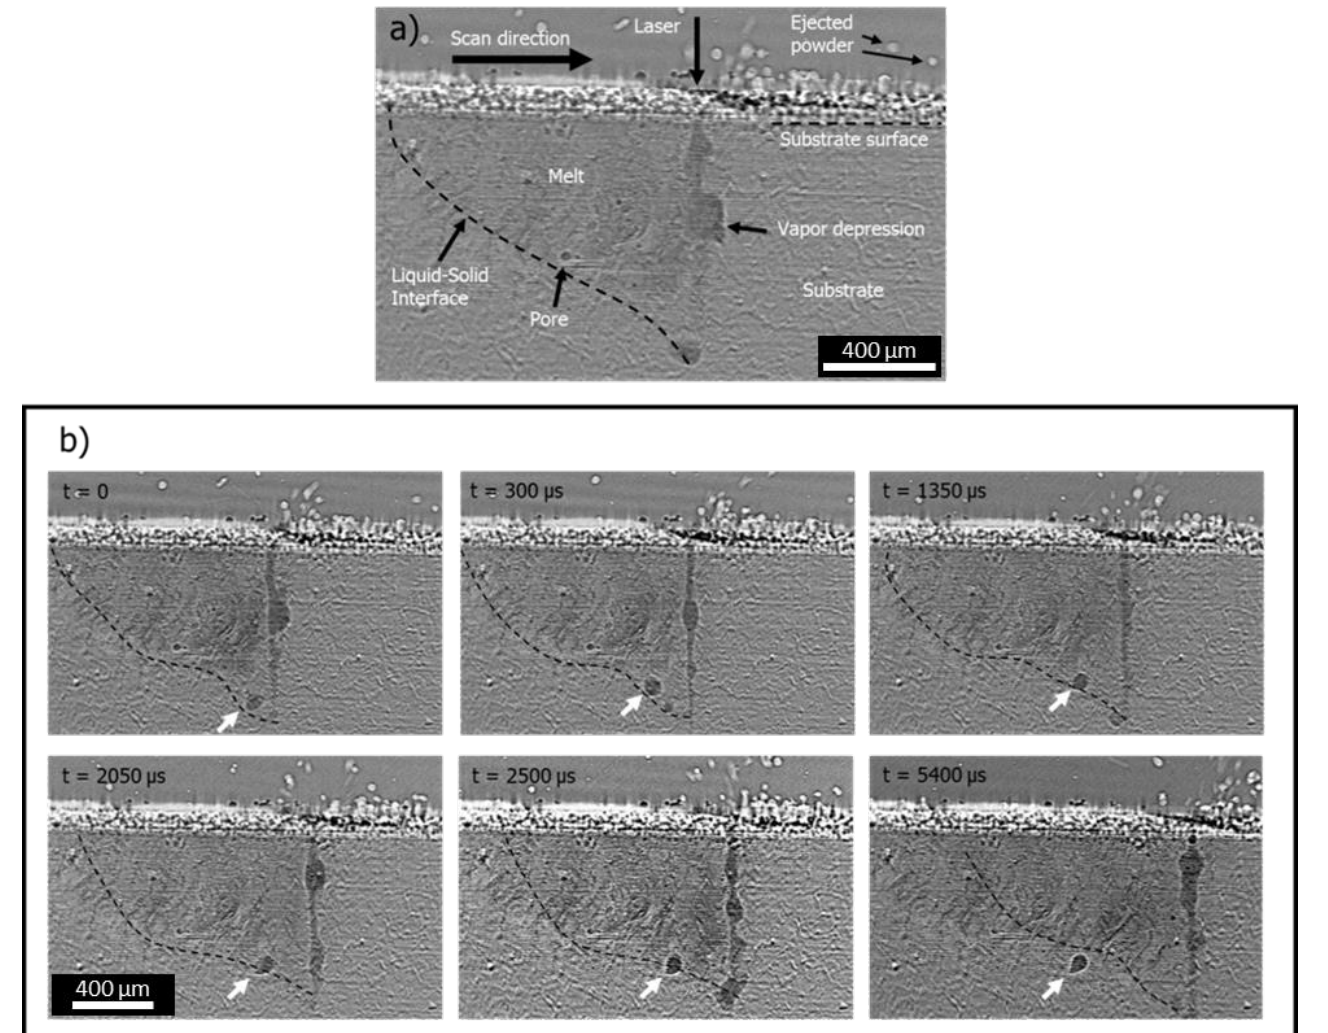
Figure 2. ( a ) In situ X-ray image of WE43 acquired during laser scanning revealing: the vapor depression, melt-pool boundary, formation of pores, and ejection of powder particles. ( b ) In situ X-ray images captured during the P = 150 W, v = 100 mm/s scan revealing the formation and solidification of one pore (white arrow). The pore originates at the base of the vapor depression, is buffeted around in the melt, and is captured and pulled toward the vapor depression by the solidification front, resulting in a balloon-shaped pore.